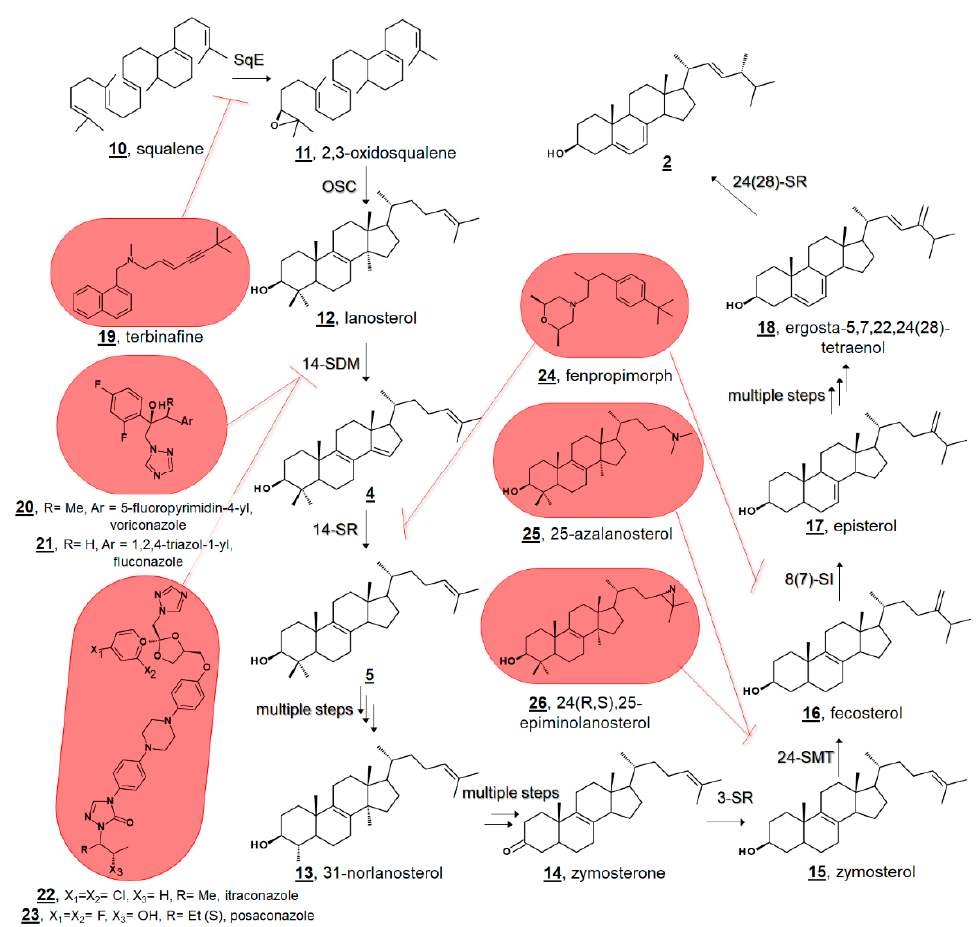
Figure 2. Truncated hypothetical pathway of fungal ergosterol 2 biosynthesis from squalene 10 . Inhibitor targets of squalene epoxidase (SqE) by allylamines, e.g., terbinafine 19 , sterol C14-demethylase (14-SDM = CYP51) by azoles, e.g., voriconazole 20 , fluconazole 21 , itraconazole 22 , and posaconazole 23 , sterol C14-reductase (14-SR) and sterol C8(7)-isomerase (8(7)-SI) by morpholines, e.g., fenpropimorph 24 , and sterol C24-methyltransferase (24-SMT) by 25-azalanosterol 25 or 24(R,S),25-epiminolanosterol 26 are highlighted at the biosynthetic steps they block. 3-SR; sterol C3 reductase, 24-SR, sterol C24 reductase.